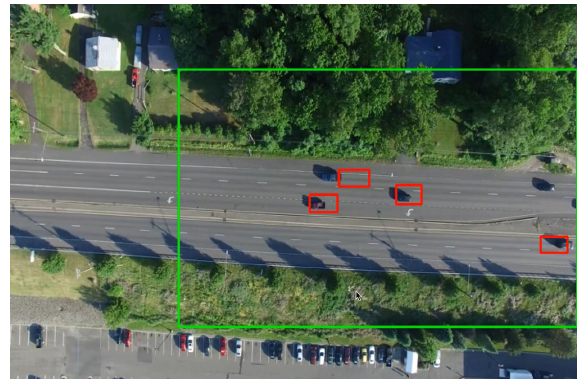
Figure 3. An example traffic scenario collected by the